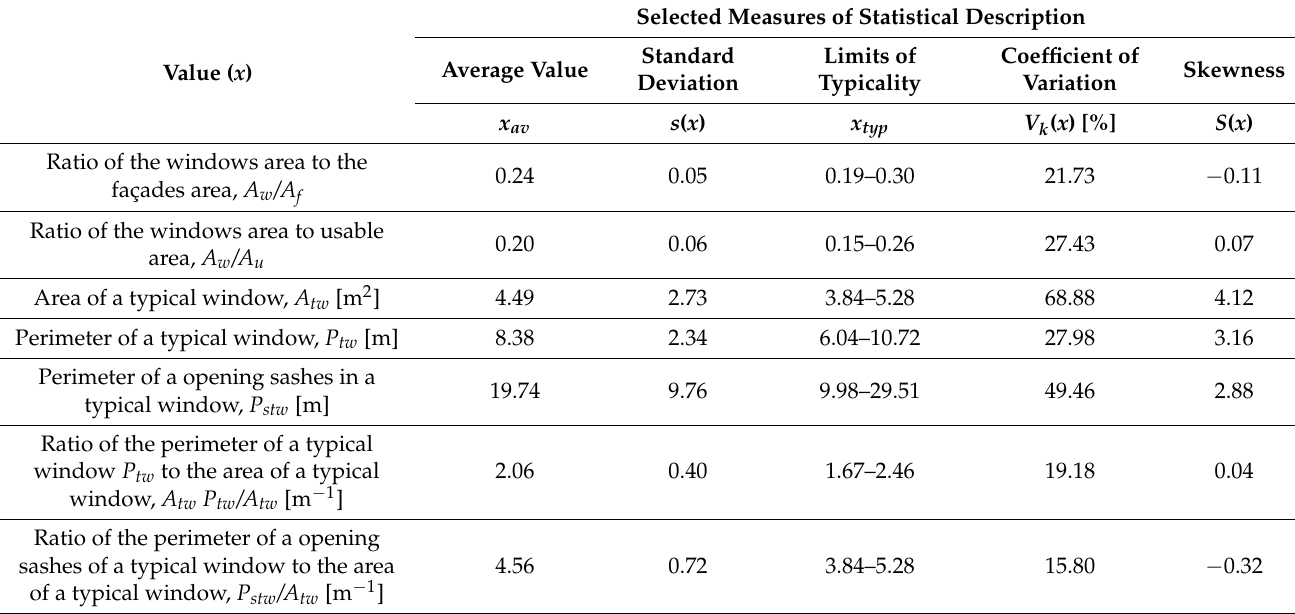
Table 3. Selected measures of statistical description for the values characterising windows in 50 education